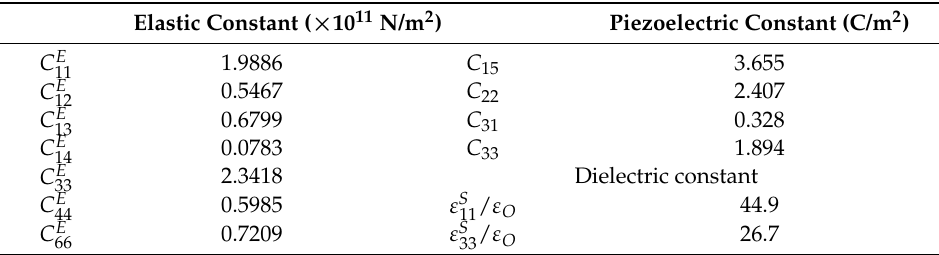
Table 1. Acoustic physical constant of LiNbO 3 of single